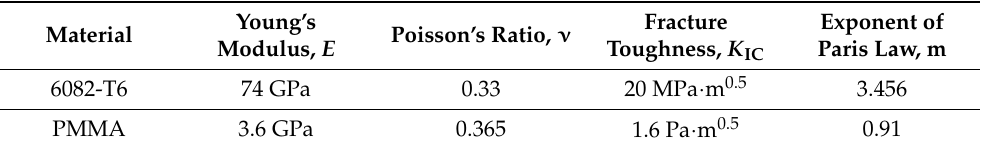
Table 1. Mechanical properties of the selected materials. Material